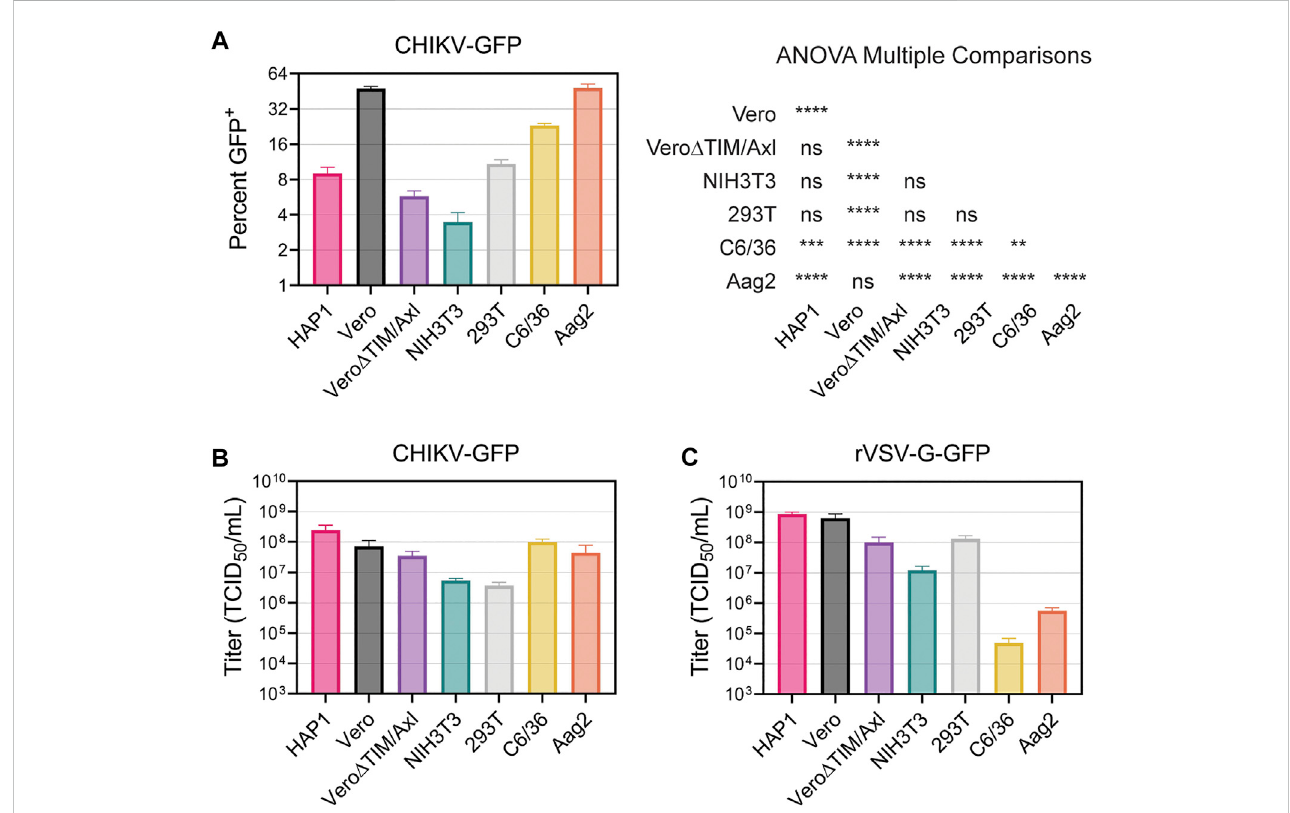
FIGURE 8 Vero and Aag2 cells display similar entry ef fi ciency of CHIKV. (A) CHIKV-GFP entry among all mammalian and mosquito cell lines used was monitored after one round of replication. Percent of GFP + cells was determined through fl ow cytometry. Statistical signi fi cance corresponding to entry ef fi ciency was calculated with a multiple comparisons ANOVA analysis: *, p < .05; ***, p < .001; ****, p < .0001. Viral stocks of (B) CHIKV-GFP 181/c25 (C) rVSV-G-GFP were titrated in each mammalian and mosquito cells used. Data are presented as the mean ± SEM from three independent experiments. The results from the ANOVA with multiple comparisons can be found in Supplementary Table